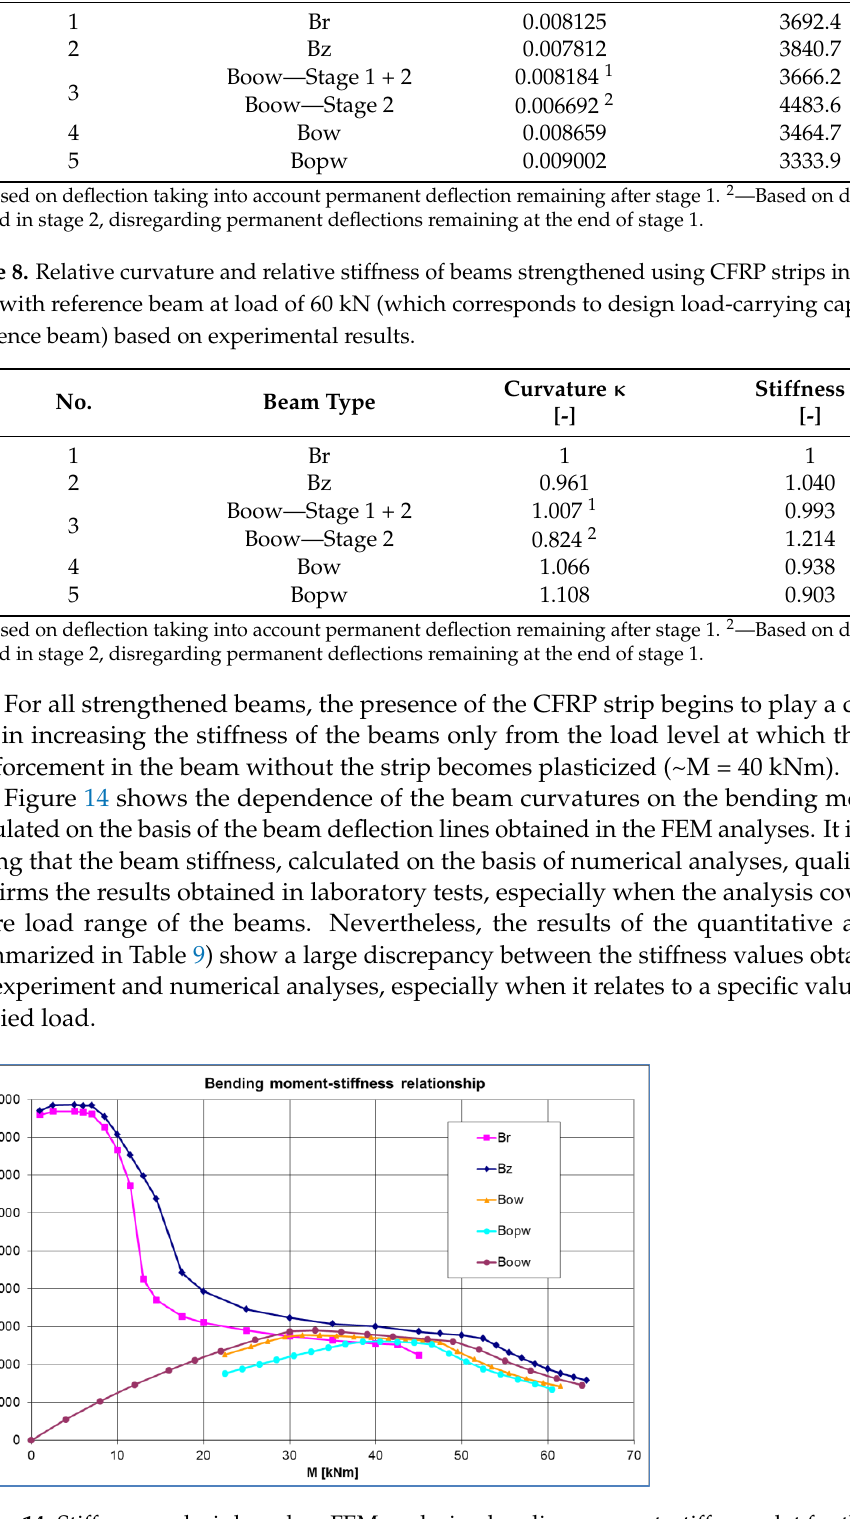
Figure 14. Stiffness analysis based on FEM analysis — bending moment – stiffness plot for the cross-section at the midspan of beams. Table 9. Stiffness and relative stiffness of beams strengthened using CFRP strips in comparison with reference beam at load of 60 kN (which corresponds to design load-carrying capacity of reference beam) based on experimental and numerical results.